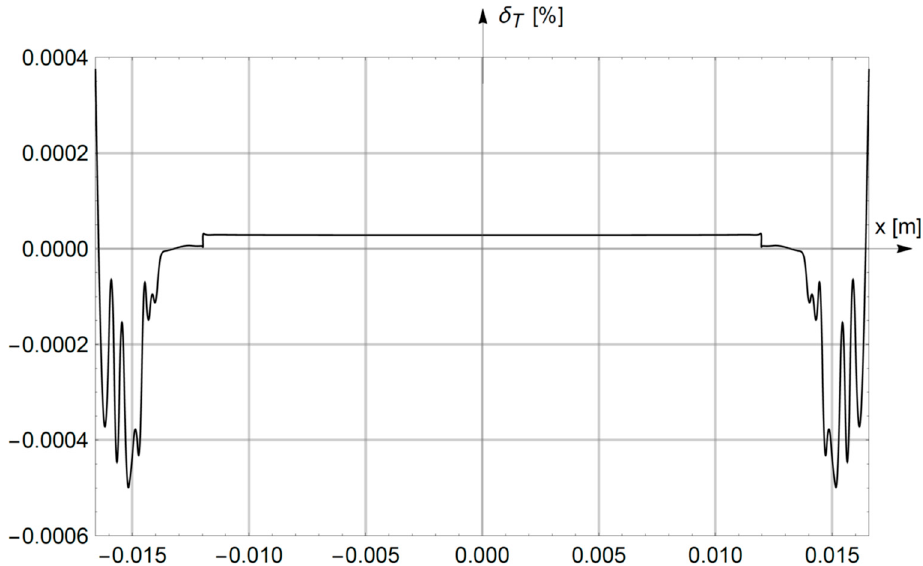
Figure 5. Relative differences (Equation (32)) between the results of the analytical–numerical method and the finite-element method for y = 0 (on the major axis of the ellipse).